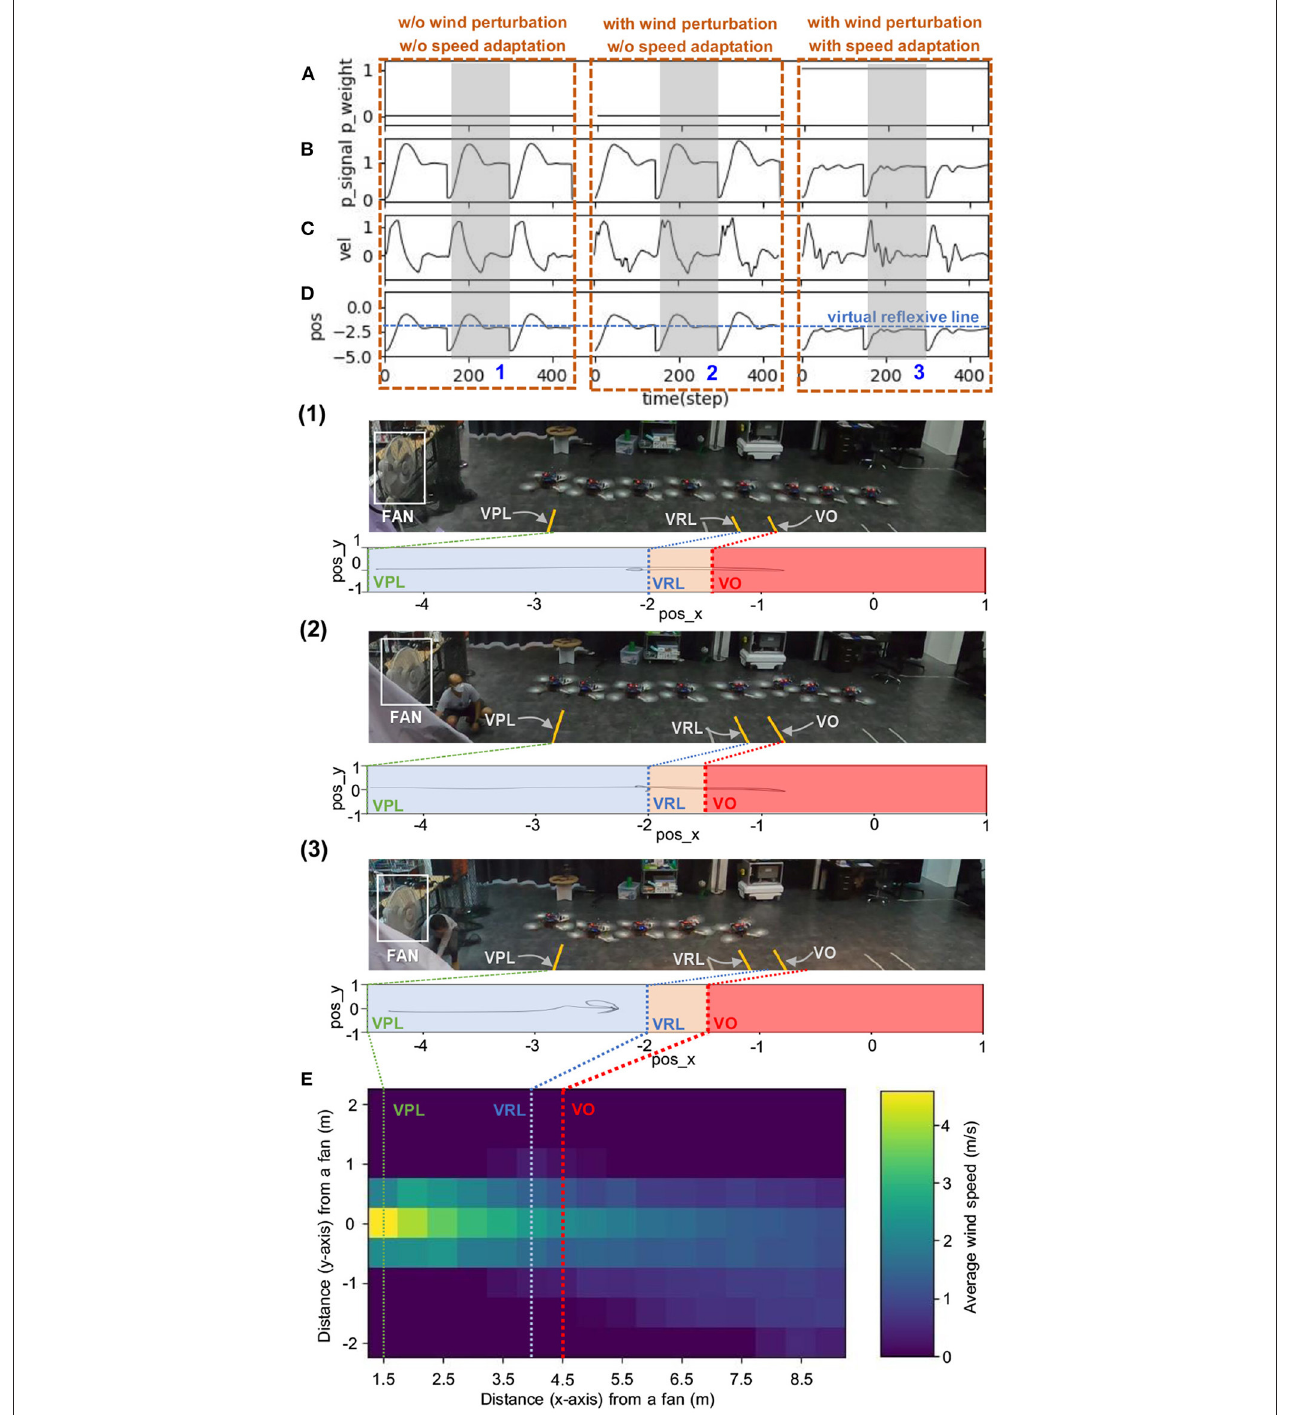
FIGURE 10 | Real-time data when flying the UAV with strong wind perturbation. The UAV flew at a maximum speed of 1.0 m/s. Each graph shows: (A) predictive weight, (B) predictive signal, (C) actual speed (x-axis) of the UAV, (D) position on the x-axis of the UAV compared to the virtual reflexive line (blue line), and (E) wind speed gradient. The three brown dashed blocks are the three different flying conditions: (1) without (w/o) wind perturbation and without (w/o) speed adaptation, (2) with wind perturbation and without (w/o) speed adaptation, and (3) with wind perturbation and with speed adaptation). The gray areas represent three periods, showing the position of the UAV with respect to the virtual predictive line (VPL), virtual reflexive line (VRL), and virtual obstacle (VO) in three snapshots, together with the corresponding estimated trajectories (1, 2, 3). A video of this experiment can be viewed on www.manoonpong.com/DSA/video3.mp4.